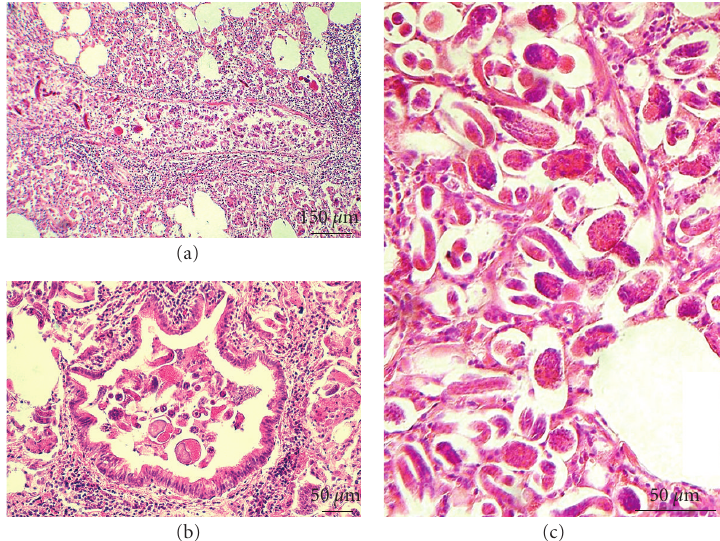
Figure 2: Goats, lungs infected with protostrongylids. (a) A nodule with M. capillaris , bronchial lumen with larvae and a desquamation of the bronchial epithelium. (b) A lobular lesion with M. capillaris , P. rufescens, and P. hobmaieri , bronchial lumen with adult parasites, larvae, alveolar macrophages, and a slight peribronchial lymphoid hyperplasia. (c) A nodule with M. capillaris , alveoli with parasite eggs and first stage larvae without thickening of the alveolar septa.